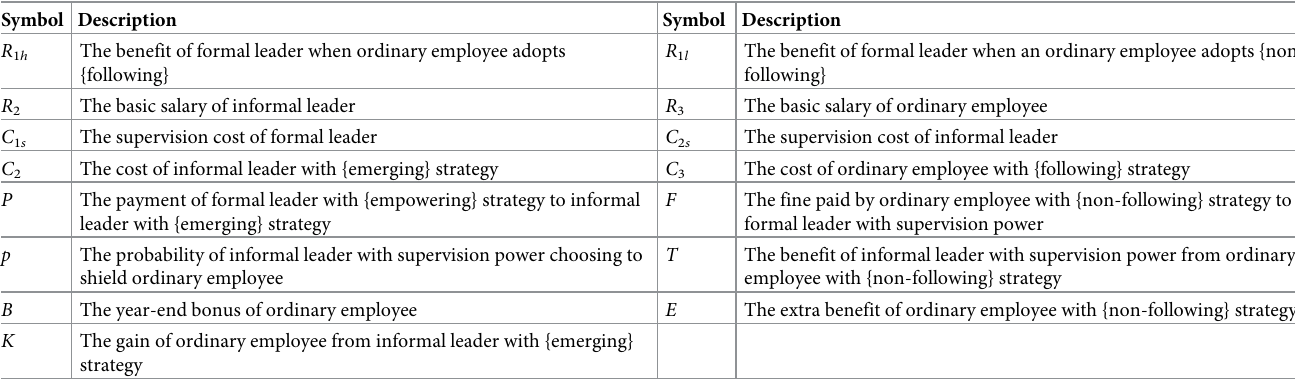
Table 1. Notations list including all key